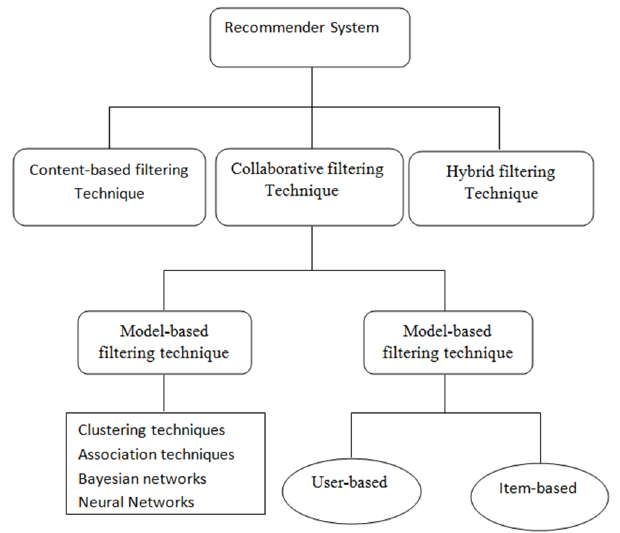
Figure 2. Hierarchy of Recommender System based on filtering.